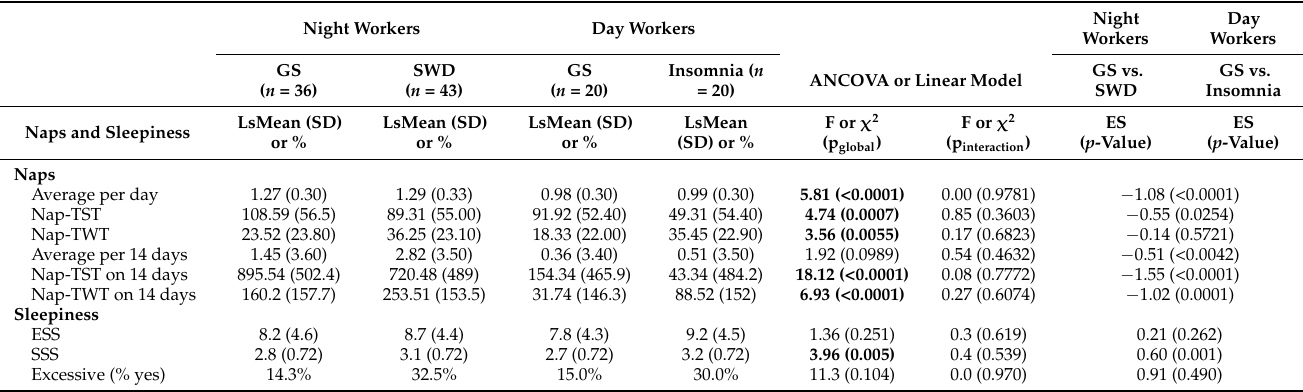
Table 4. Least square mean (LsMean) and standard deviation (SD) for nap and sleepiness according to work schedule (night or day workers) and sleep disorder (good sleep or SWD/insomnia). Night Workers Day Workers Night Workers Day